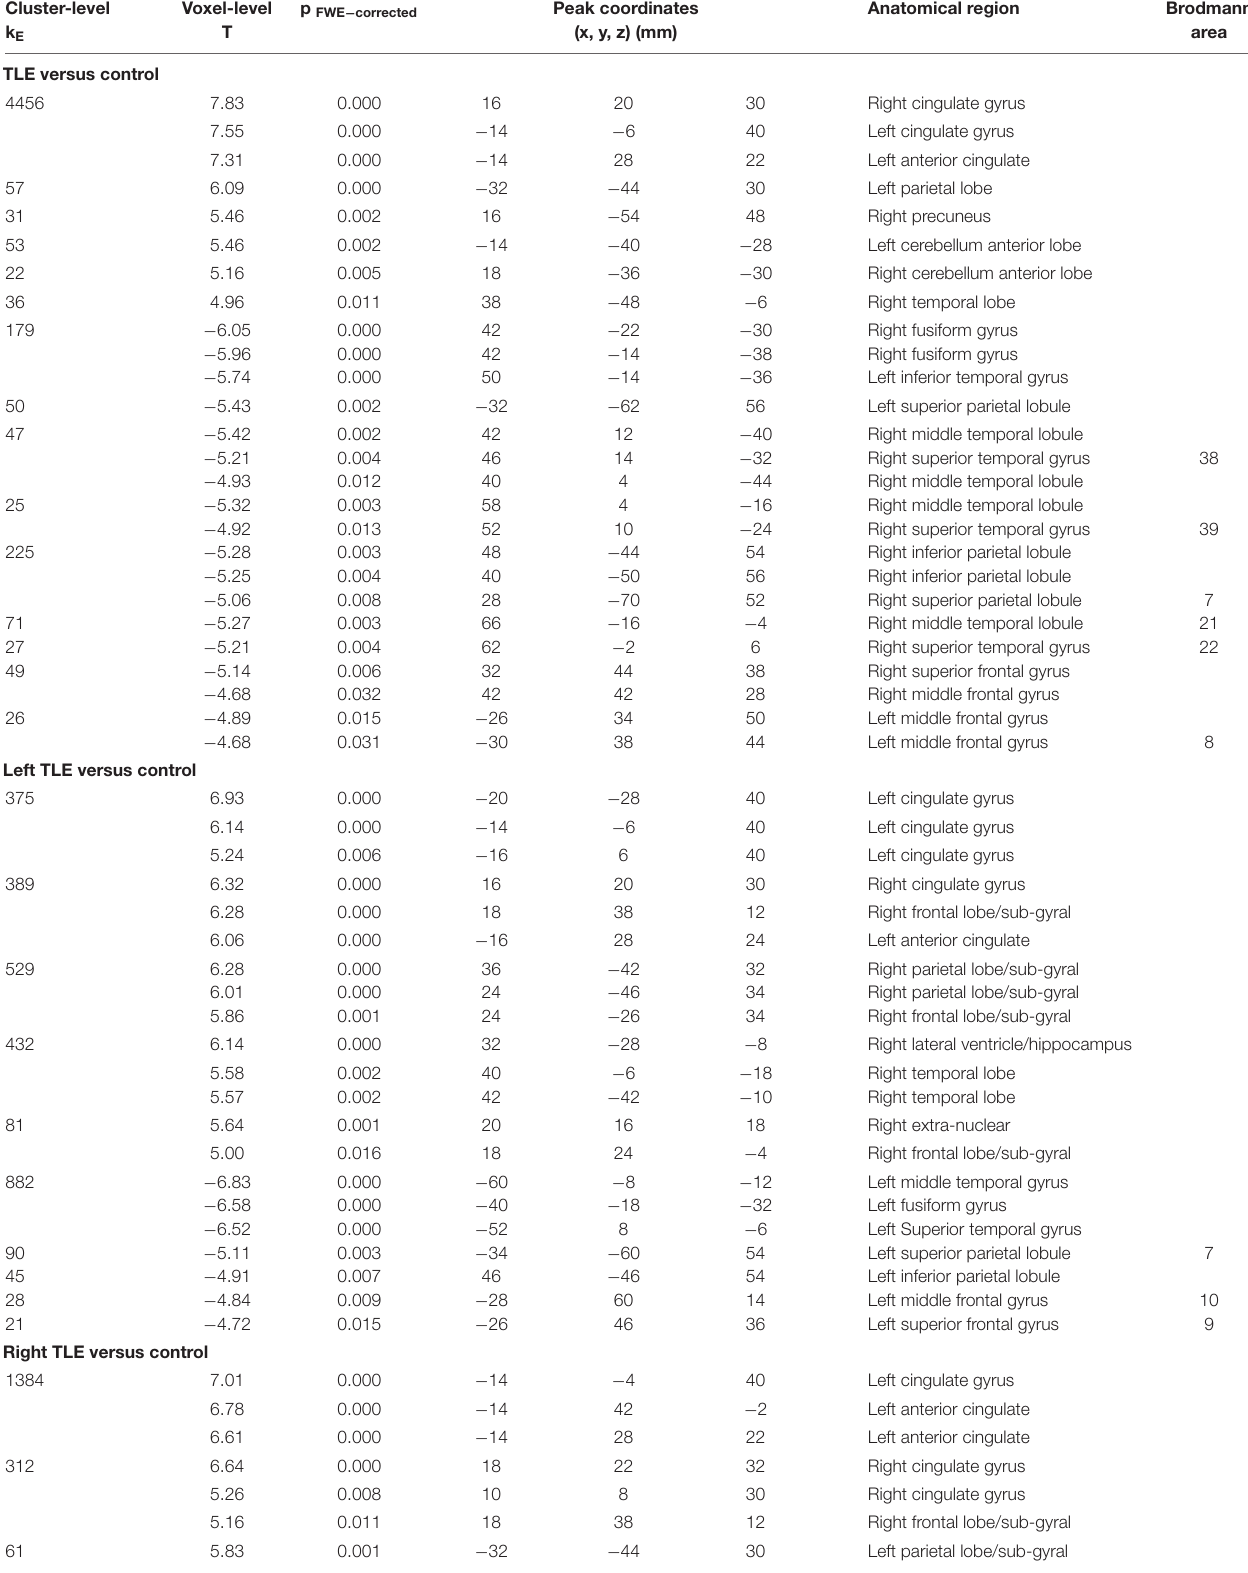
Peak coordinates (x, y, z) (mm)